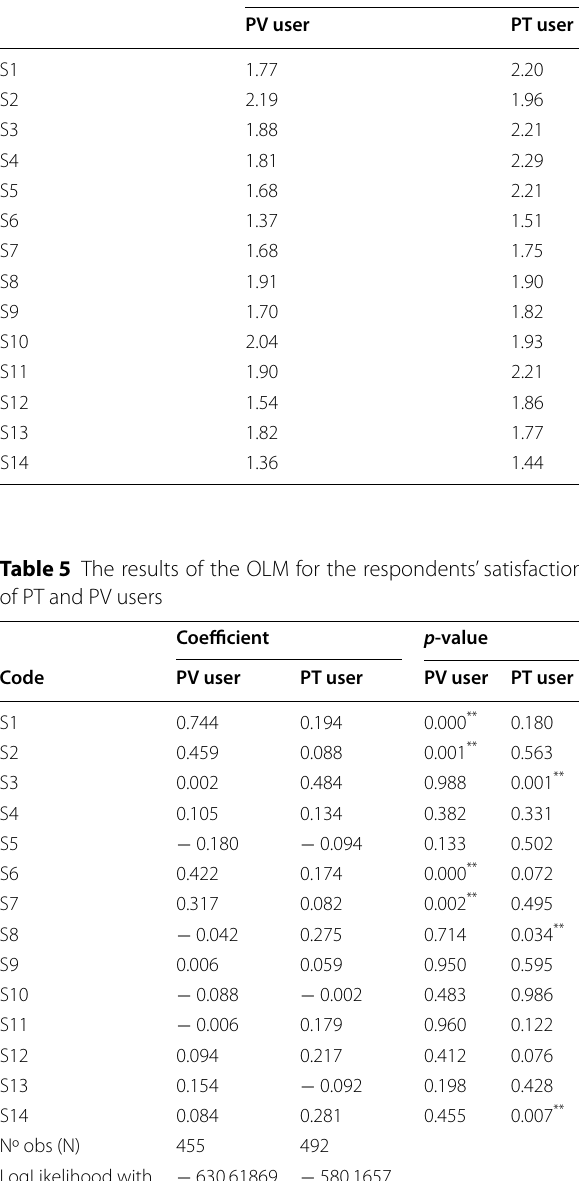
Table 4 The collinearity results of the independent variables Code